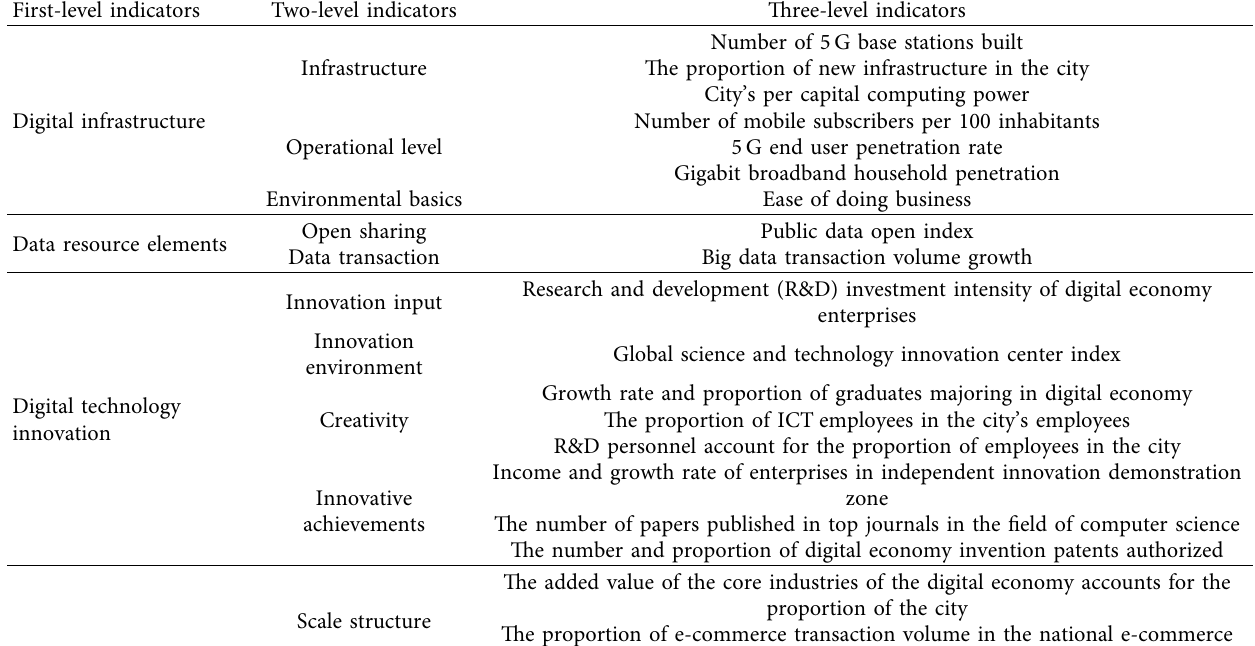
Table 1: Digital economy development quality